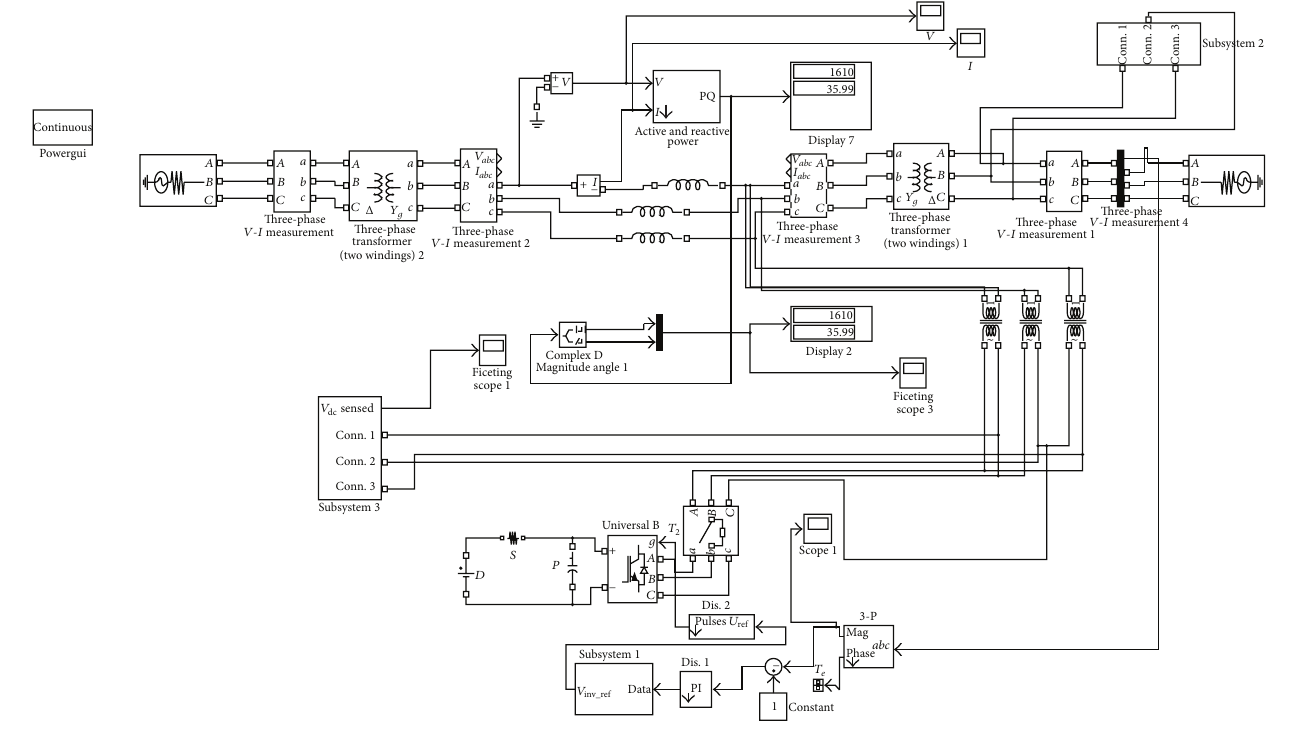
Figure 4: Proposed PIGBT-IDVR Simulink model.